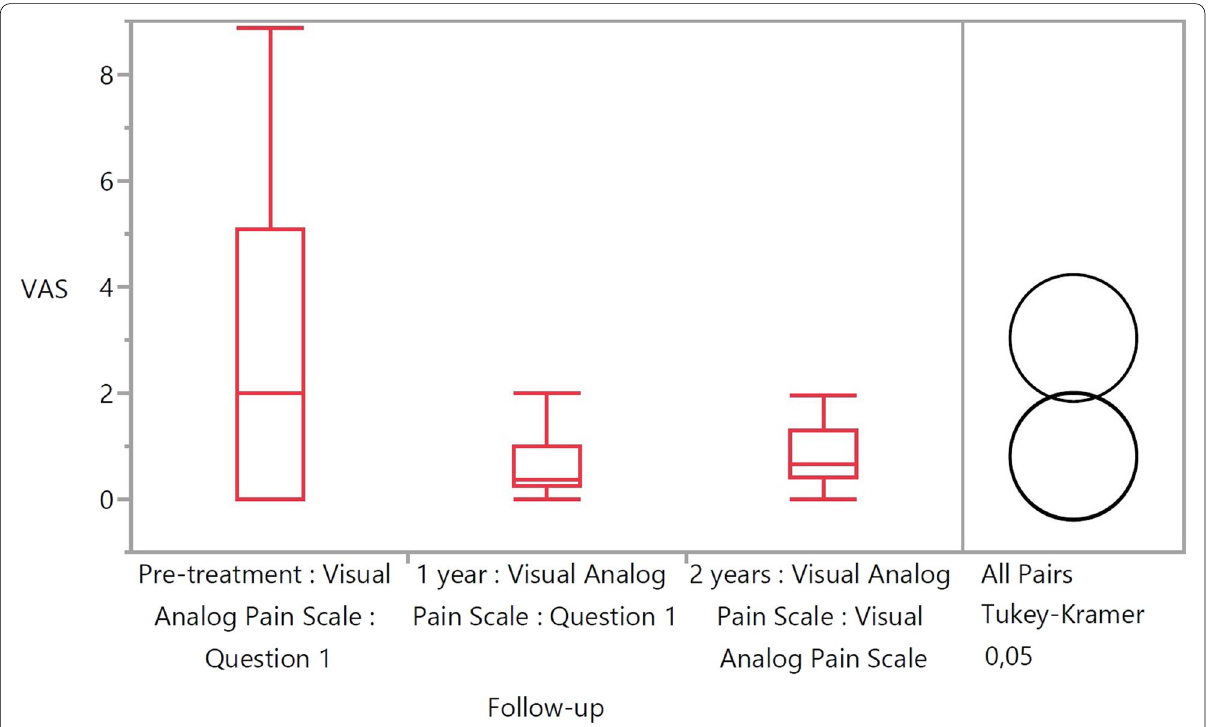
Fig. 3 Chart demonstrating the VAS-pain scores at the different time